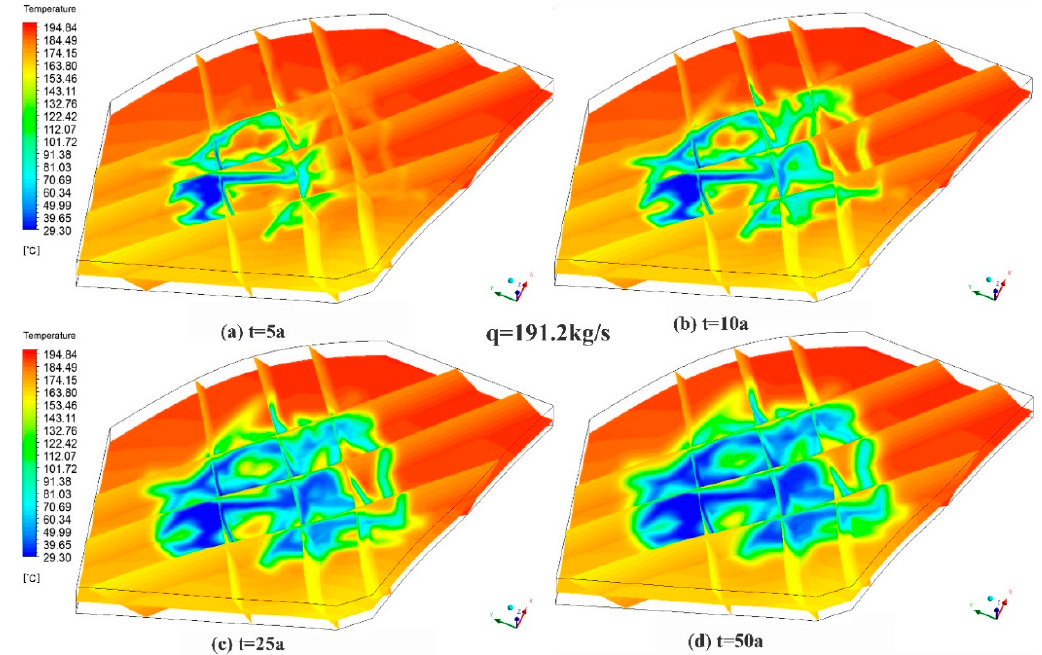
Figure 12. Temperature contour at injection rate of 191.2 kg/s.